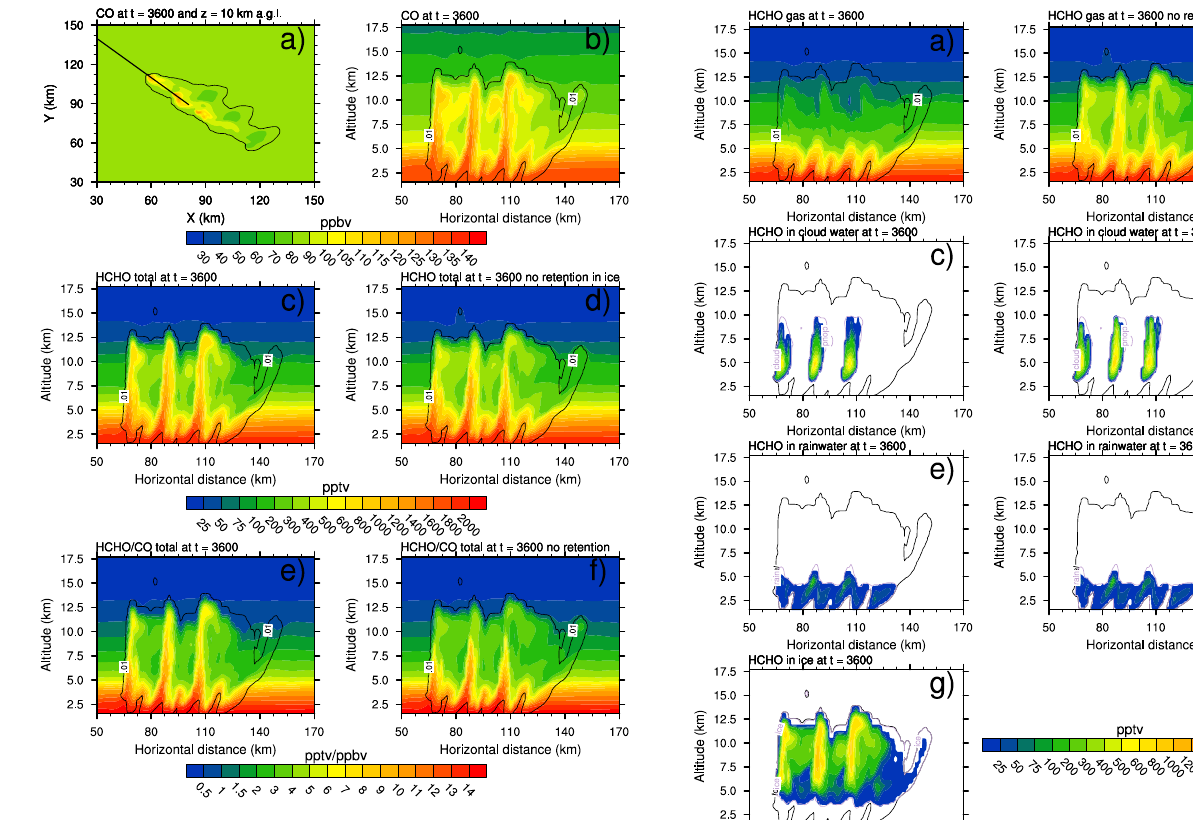
Fig. 11. STERAO case – results at t = 3600s for (a) horizontal Figure 11. STERAO case: results at t = 3600 s for (a) horizontal cross section of CO mixing 2 cross section of CO mixing ratio inppbv at 10kma.g.l., (b) vertical ratio in ppbv at 10 km a.g.l., (b) vertical cross section along the segment indicated on (a) for 3 cross section along the segment indicated on (a) for CO mixing ra- CO mixing ratio in ppbv, (c) same vertical cross section for HCHO total mixing ratio (gas + 4 tio inppbv, (c) same vertical cross section for HCHO total mixing cloud water + rainwater + precipitating ice) in pptv for simulation with retention in ice, (d) 5 ratio (gas + cloud water + rainwater + precipitating ice) inpptv same as (c) for simulation without retention in ice, (e) same vertical cross section for the ratio 6 for simulation with retention in ice, (d) same as (c) for simulation of total HCHO to CO in pptv/ppbv for simulation with retention in ice, (f) same as (e) for 7 without retention in ice, (e) same vertical cross section for the ratio of total HCHO to CO inpptvppbv − 1 for simulation with retention simulation without retention in ice. 8 in ice, and (f) same as (e) for simulation without retention in ice.